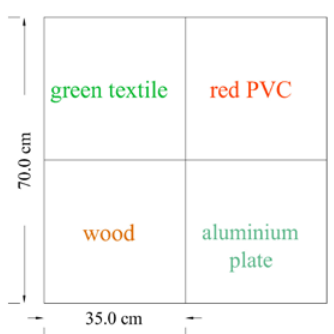
Figure 9. The segment no 3: Different paint of the same colour (image obtained with RGB camera) For all element of this segment spectral reflectance coefficients were obtained in the laboratory conditions. As it is shown on the Figure 10, spectral characteristics of red colours as green are quite similar in the visible spectrum range, however it is possible to distinguish them in infrared spectral range.